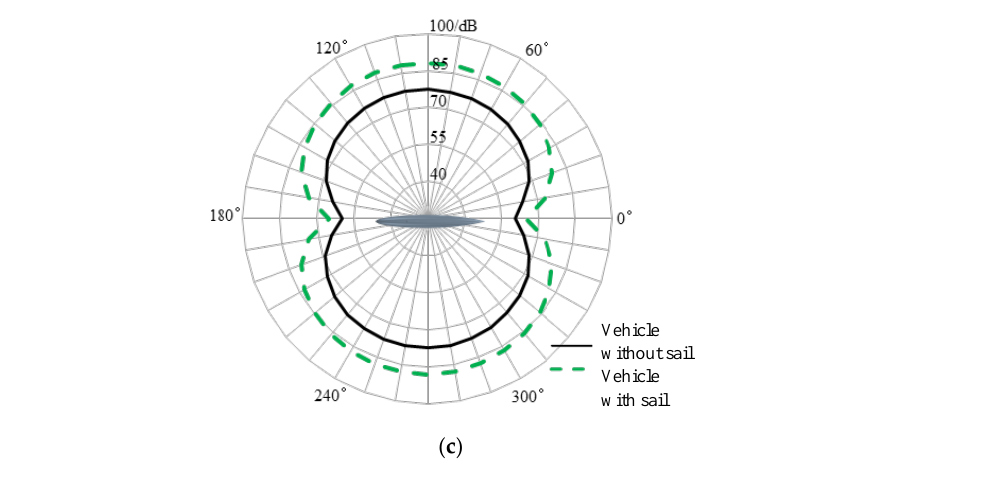
Figure 12. Directivity of sound pressure levels at transverse cross section, longitudinal section, and horizontal section of underwater vehicle with hull: ( a ) transverse cross-sectional directivity; ( b ) longitudinal section directivity; ( c ) horizontal section directivity.